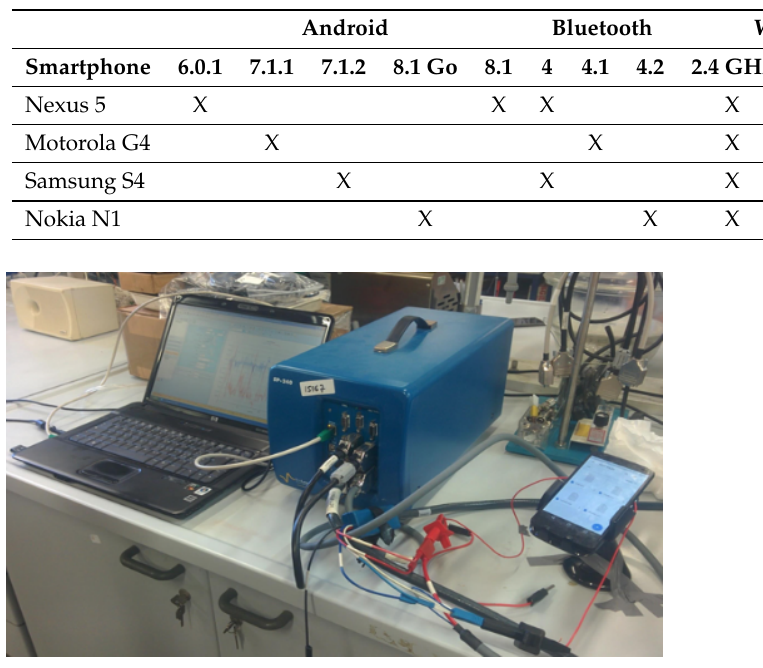
Figure 2. Experiments in our electrochemistry